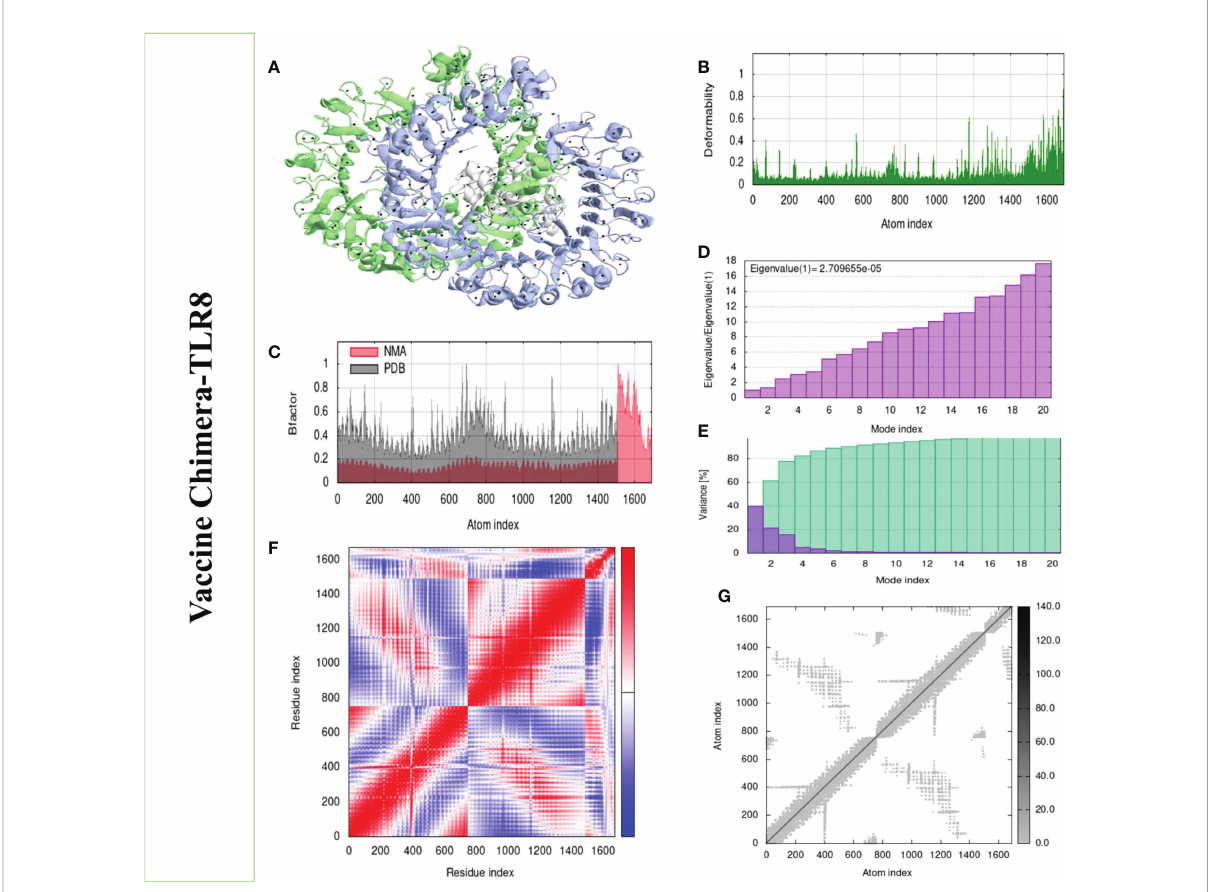
FIGURE 9 Normal mode analysis of the vaccine-TLR-8. (A) Mobility of re fi ned protein – protein complex. (B) In relation to atom deformability. (C) In relation to atom B factors. (D) Eigenvalue in relation to modes. (E) The variance of structural changes. (F) In relation to residue covariance. (G) In relation to atom elastic